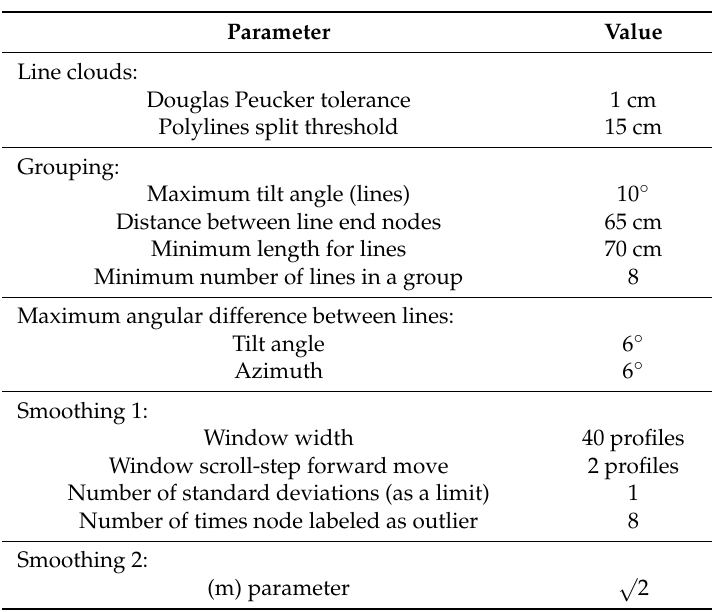
Table 1. Settings applied to the test